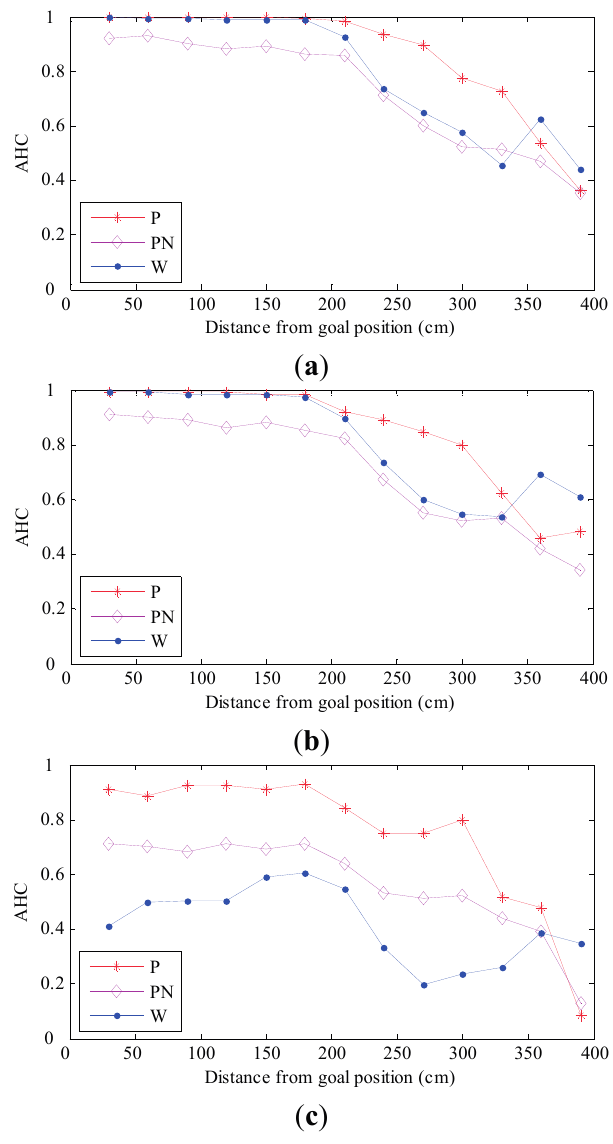
Figure 9. Average homeward component (AHC) results. ( a – c ) The distribution of AHC